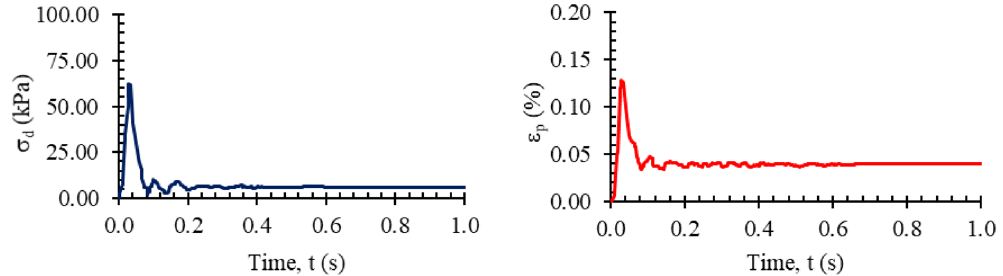
Figure 5. Time dependent variation in the deviator stress and deformation at 96th repetition of the 3rd load series.